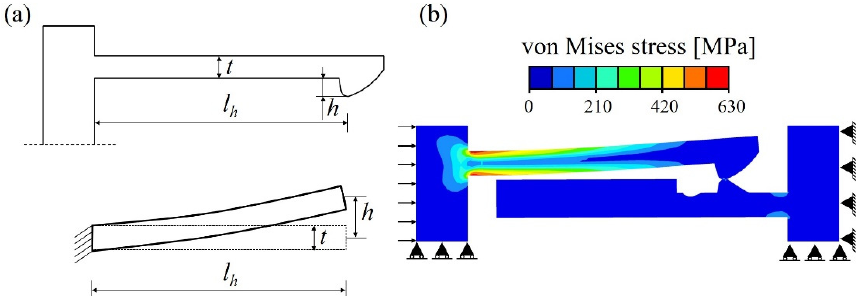
Figure A1. Model and simulations for dimensioning the snap-fit mechanism. ( a ) Contour of a snap-fit hook and simplified cantilever beam, ( b ) von Mises stresses visualized through numerical simulation with implemented boundary conditions.